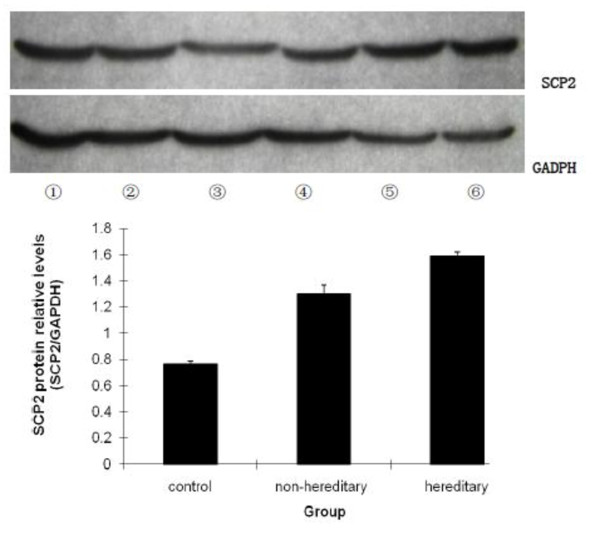
The protein levels of SCP2 in hereditary gallstone group, non-hereditary gallstone group and control group. All samples were analyzed by Western blot using anti-SCP2 antibody, and GAPDH was used as the internal control. Results were shown as SCP2/GAPDH ratio in arbitrary densitometric units representing SCP2 protein relative levels. Lane ① and ② are from control group, Lane ③ and ④ from non-hereditary group, and Lane ⑤ and ⑥ from hereditary group. SCP2 protein was expressed at higher level in hereditary cholesterol gallstone patients than that in non-hereditary cholesterol gallstone patients, and the difference was statistically significant, P < 0.05. SCP2/GAPDH ratios in hereditary, and non-hereditary cholesterol gallstone patients were 1.5898 ± 0.0316, 1.3032 ± 0.0664 respectively, which were both higher than that in control group,0.7637 ± 0.0258, P < 0.05.